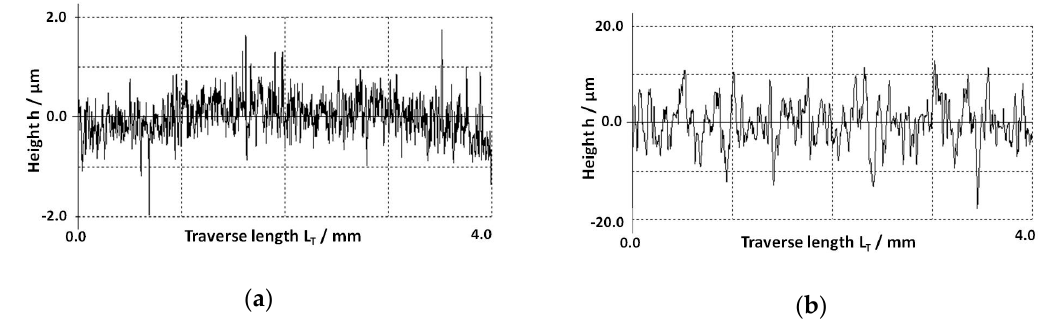
Figure 2. Surface roughness profiles of IN 625 performed by standard contact HOMMEL Werk T8000 profilometer on: ( a ) Ground (1000 grit) and ( b ) grit-blasted Ni-base superalloy.